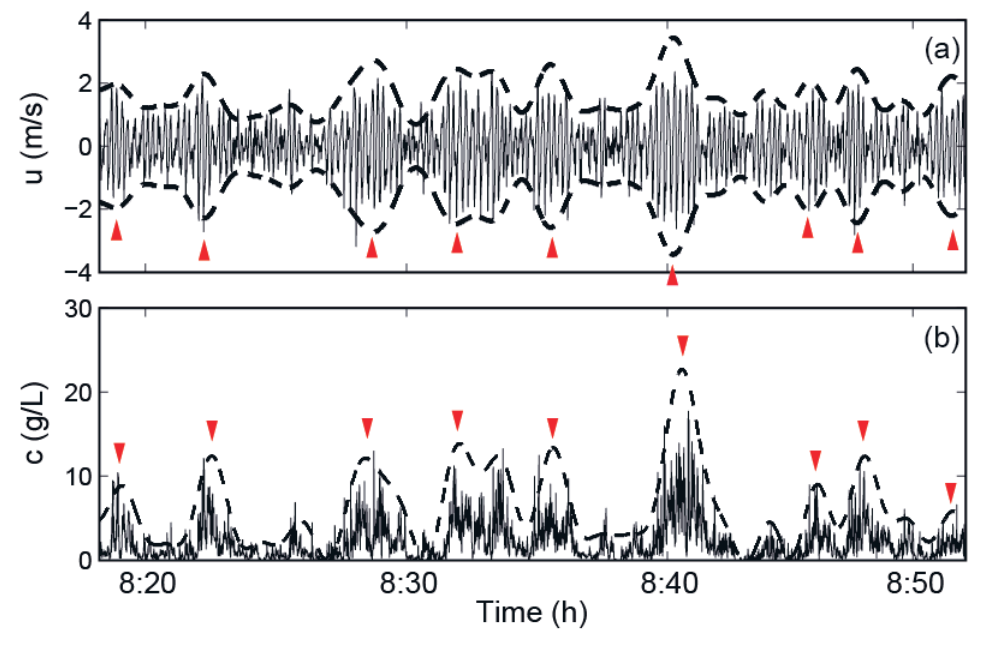
Figure 3. Time series of ( a ) cross-shore current velocity u ( z = 0.25 m; solid line) and the envelope function of u (thick, dashed lines); and ( b ) suspended sediment concentration c ( z = 0.05 m; solid line) and low-pass-filtered c (thick, dashed line) (just outside of the breaker line, over a flat bed, Mullaloo Beach, Western